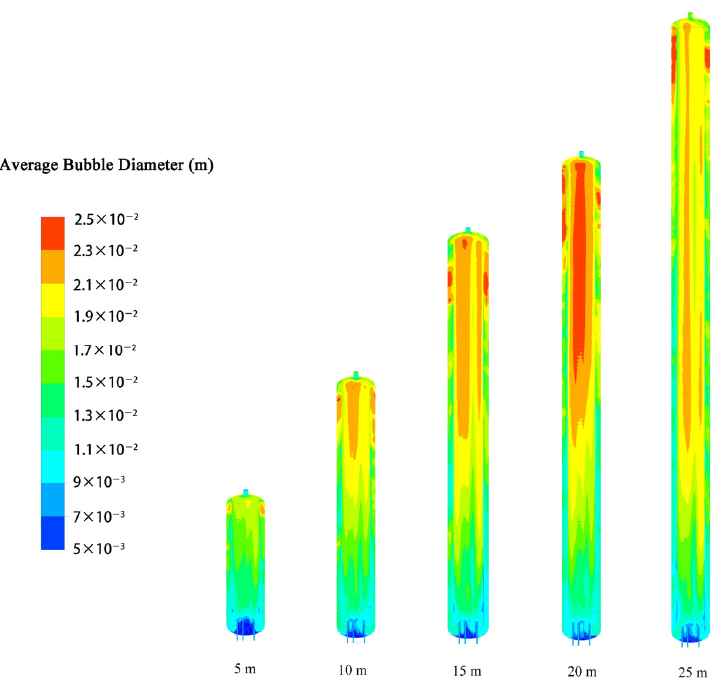
Figure 15. Average bubble diameter distribution at different total column heights with U Gr of 0.0389 m/s.